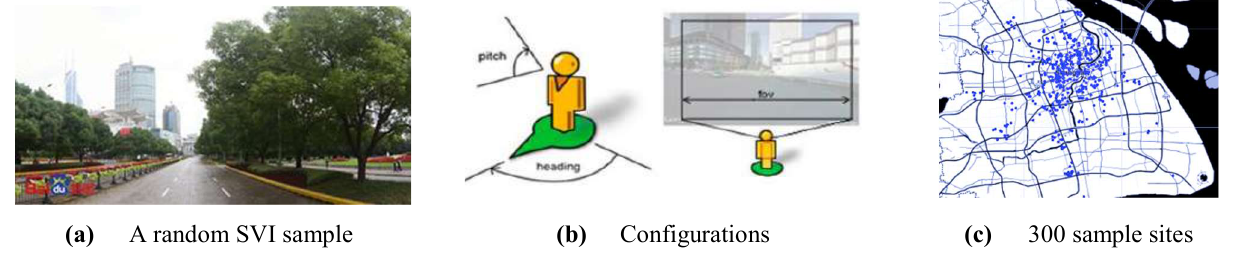
Figure 3. Downloading SVIs from Baidu. ( a ) A SVI sample selected randomly. ( b ) Consistent viewpoints: the “heading” (view direction) was set parallel to the street centerline, the “FOV” (horizontal field of view) was 120 degrees, and the “pitch” (the up or down angle of the camera) was 0 degree. In addition, the resolution was 640 × 360 pixels. ( c ) 300 training images were sampled across a range of citywide locations in Shanghai.